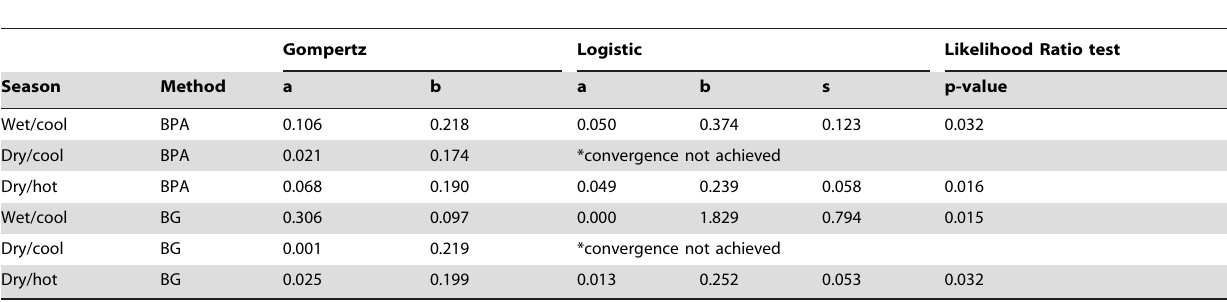
Table 5. Parameters for the Gompertz and Logistic models used to describe the predicted age structures of Aedes aegypti collected from Tri Nguyen